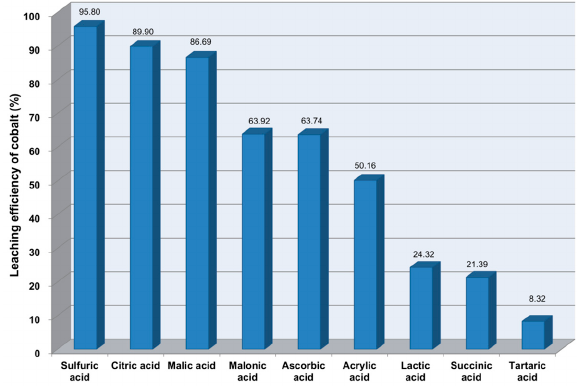
Figure 1. Cobalt leaching efficiency comparison from spent batteries for each leaching agent used in this study.